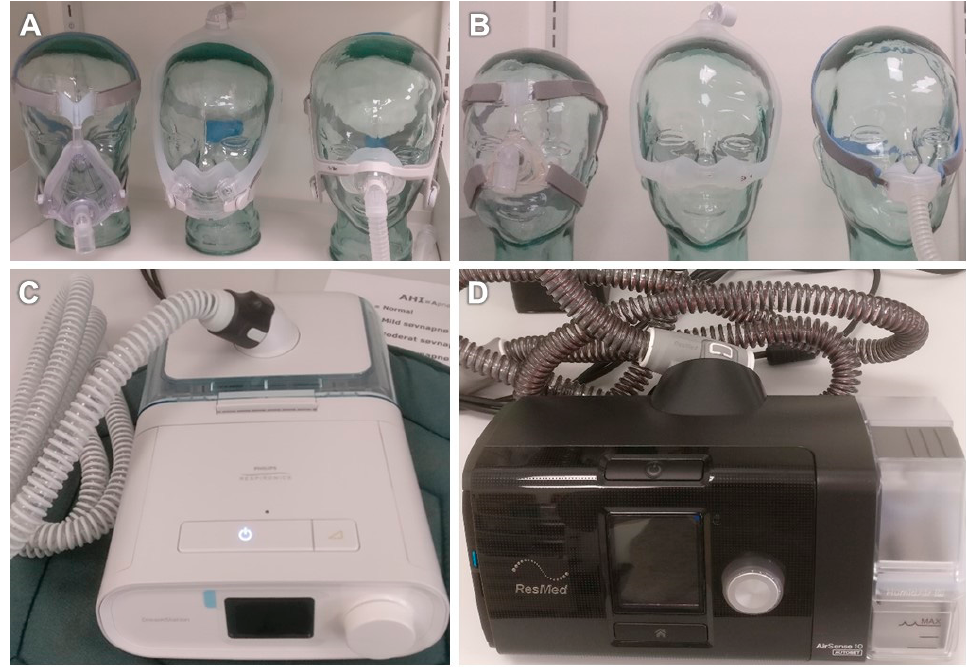
Figure 2. Continuous positive airway pressure (CPAP) machines and masks. ( A ) Nasal and oronasal masks, ( B ) nasal masks, ( C ) Philips CPAP machine and ( D ) ResMed CPAP machine.